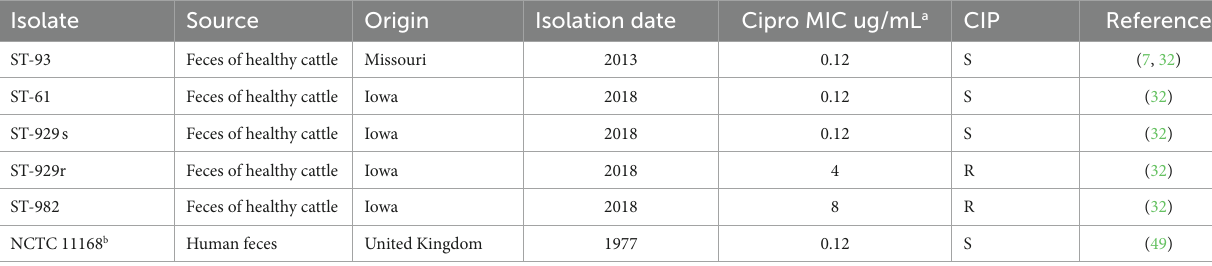
TABLE 1 Characteristics of Campylobacter jejuni strains used in the current study.